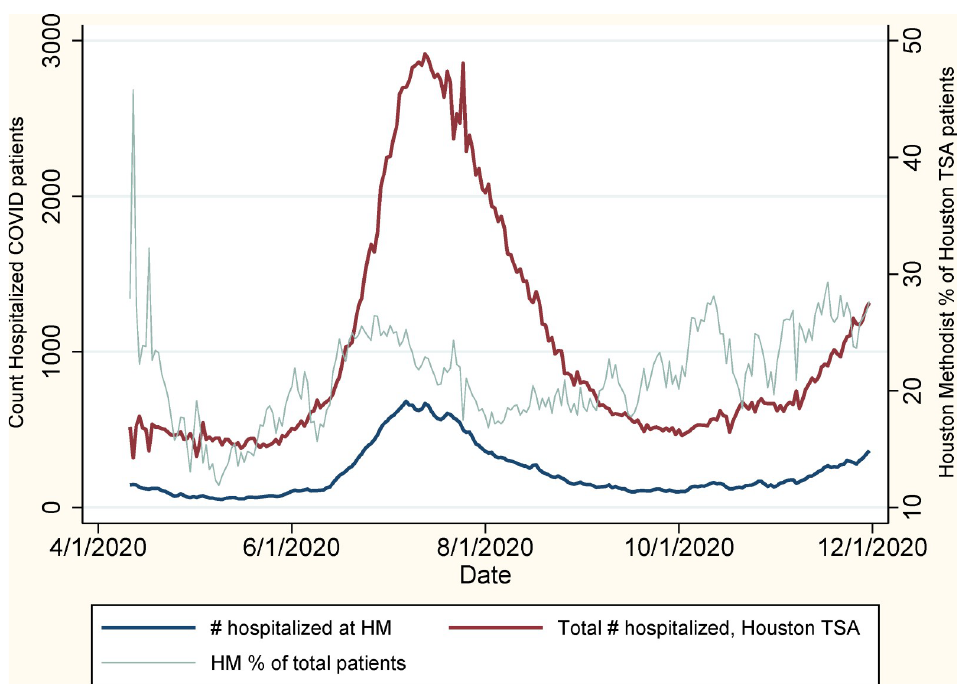
Fig 2. Hospitalized COVID-19 patients in Houston Trauma Service Area (TSA-Q) and Houston Methodist Hospital System over